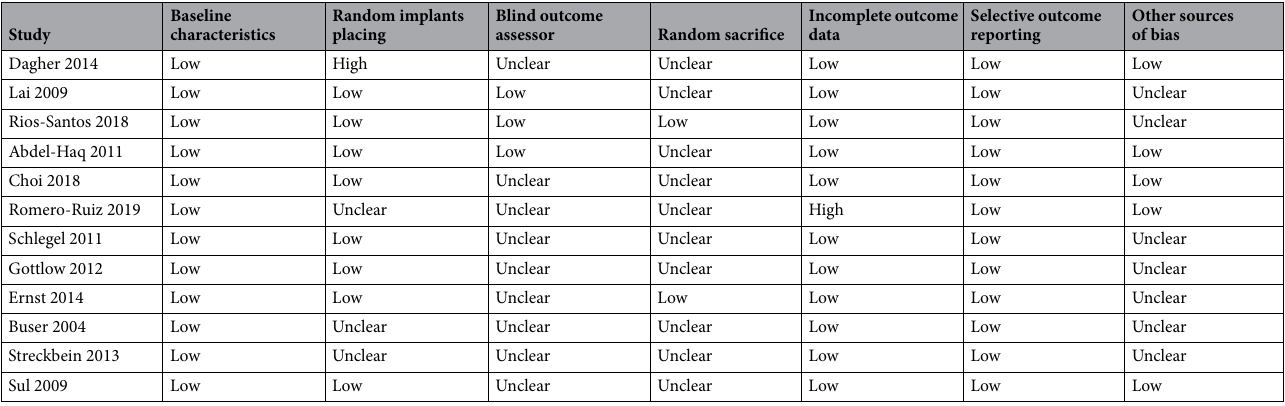
Table 3. Risk of bias assessment of included